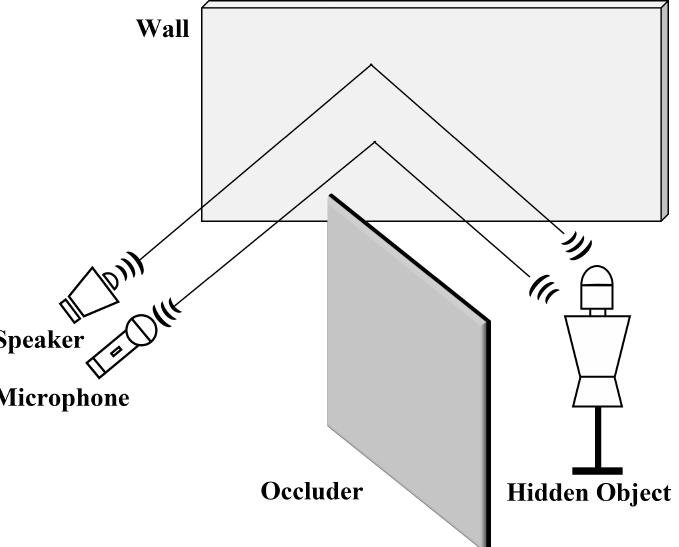
Figure 1. Typical acoustic NLOS setup. Object hidden by the obstacles is not directly visible from the observer’s point of view. The speakers emitted chirp signals toward the relay wall, and the microphones recorded the signals reflected off the hidden